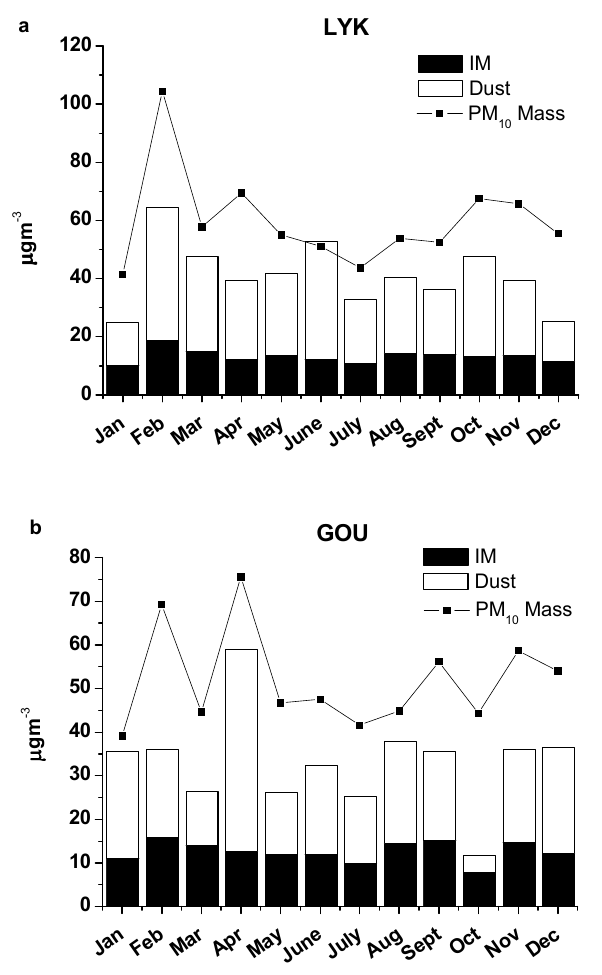
Fig. 10. Mass Closure (Ionic Mass and Dust) versus measured PM 10 : (a) LYK and (b) GOU.